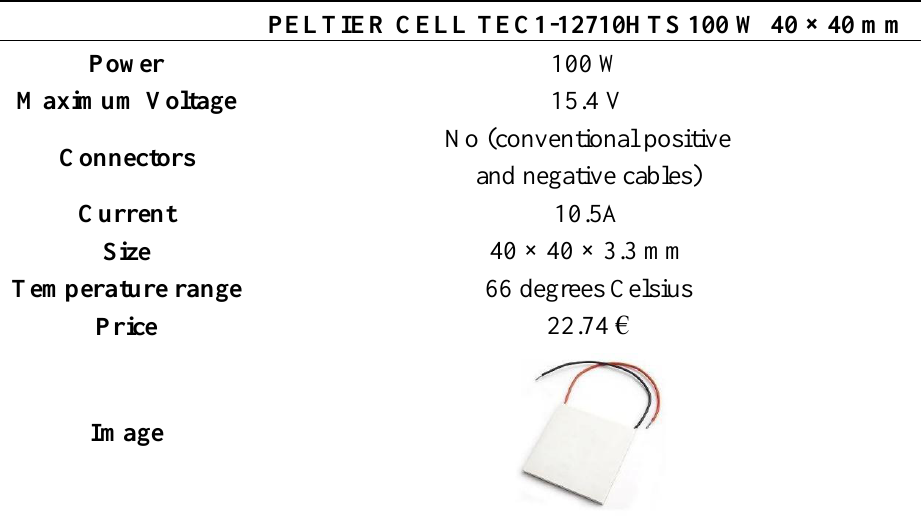
Table 10. Technical characteristics of the Peltier cell used.